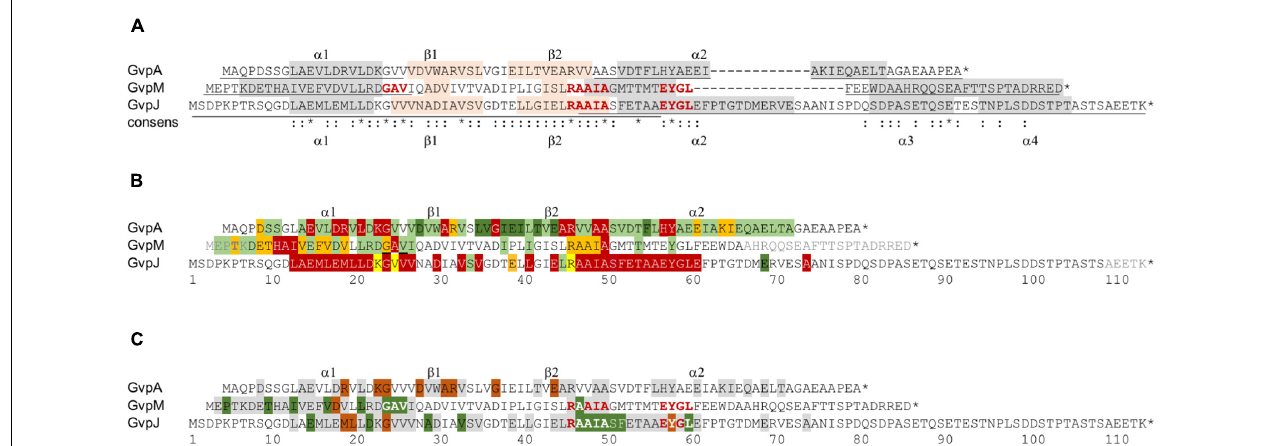
FIGURE 8 | Comparison of the results on GvpA, GvpJ, and GvpM. (A) Alignment highlighting the structural features of the three proteins. The α -helical regions predicted are shaded in gray and the β -sheet regions in pink. The sequence motifs GAV, RAAIA, and EYGL are marked in red letters. Underlined are the sequences present in the N- or C-terminal fragments of GvpA, GvpJ, and GvpM used in our studies. The consensus is marked on the bottom: *, three identical residues; two identical aa. (B) Alignment comparing the results on the Vac phenotype in the respective (cid:49) X + X mut transformants (X = A, J, or M). Vac + transformants are shaded in green (wild-type gas vesicles); dark green indicates that a substitution by alanine yields cylinder-shaped gas vesicles; orange indicates that a substitution yields Vac ± transformants. Residues where a substitution leads to a Vac − phenotype are shaded in red. Substitutions in GvpJ leading to unstable gas vesicles are shaded in yellow. The residues near the N- or C-terminus shown in gray could be deleted without an effect on gas vesicle phenotype. Residues not shaded were not explored. (C) Comparison of the results on the A/F interaction (Völkner et al., 2020), and of the J/L and M/L interaction studies presented in this report. The aa shaded in green leads to a higher fluorescence in the transformants, whereas aa shaded in dark red yielded a lower fluorescence when substituted (mostly by alanine). The residues shaded in gray yielded a similar GFP fluorescence as the wild-type proteins GvpA, GvpJ, or GvpM. Residues not shaded were not investigated. The star at the end of the sequences marks the end of each amino acid